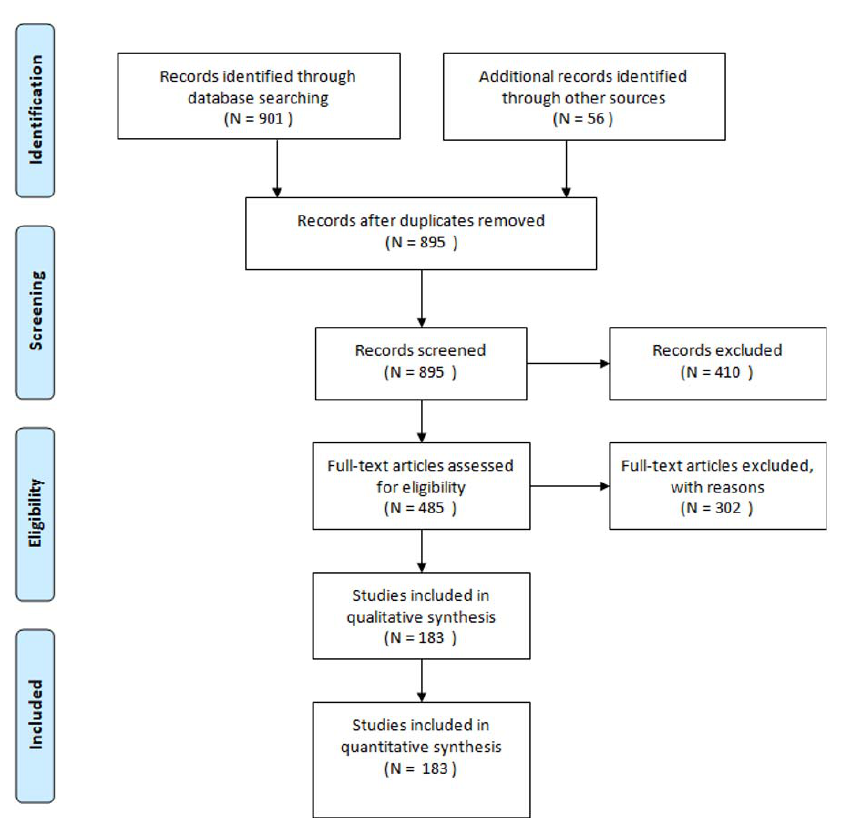
Figure 1. Preferred R eporting I tems for S ystematic Reviews and M eta- A nalyses (PRISMA) 2009 Flow